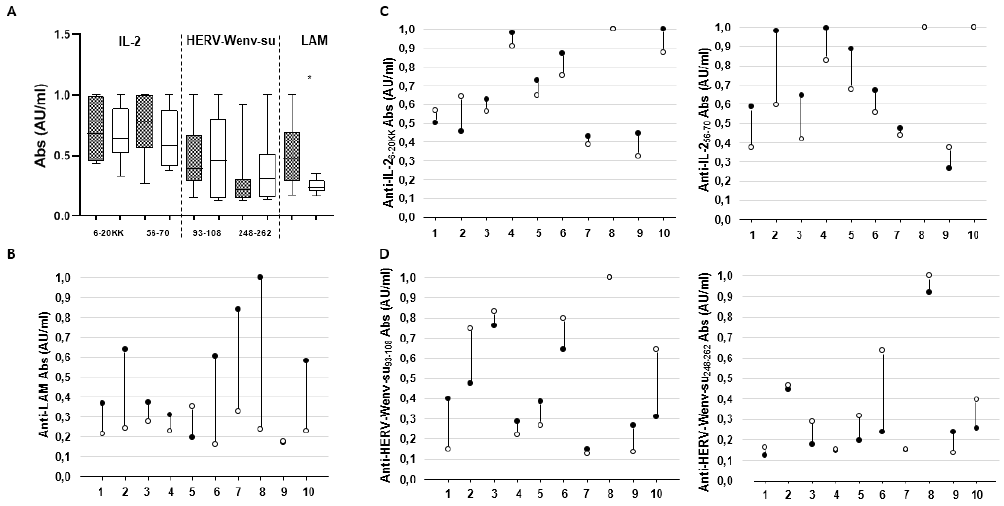
Figure 2. Changes in antibody (Abs) profiles of MS patients after a one-year follow-up. Overall Abs levels specific for each antigen are shown along with corresponding peptide position indicated at the base ( A ). Changes in Abs response to lipoarabinomannan (LAM) glycolipid ( B ), as well as IL-2 ( C ) and HERV-Wenv-su ( D ) peptides are also shown for single patients. Dark grey bars and black dots correspond to T0 sampling, while light grey bars and white dots indicate values after 12 months of MS therapy or the lack of therapy. On the X -axis, patient reference numbers are reported.